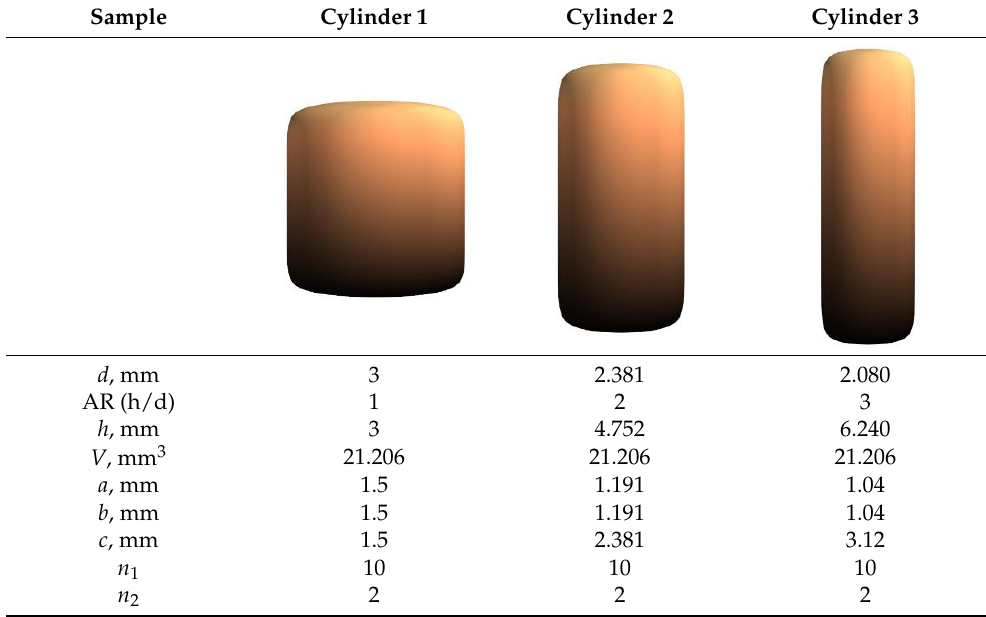
Table 1. Dimension and parameters of cylindrical particles generated using SQ approach.